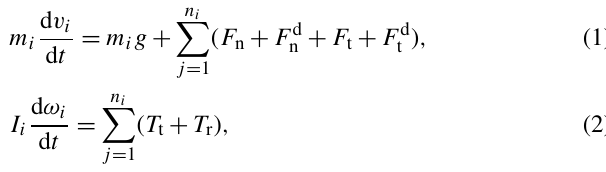
Figure 3. (a) Simulation diagrams of the rice mill. (b) Distribution of rice particles in the milling chamber. (c) Different regions in the circumferential